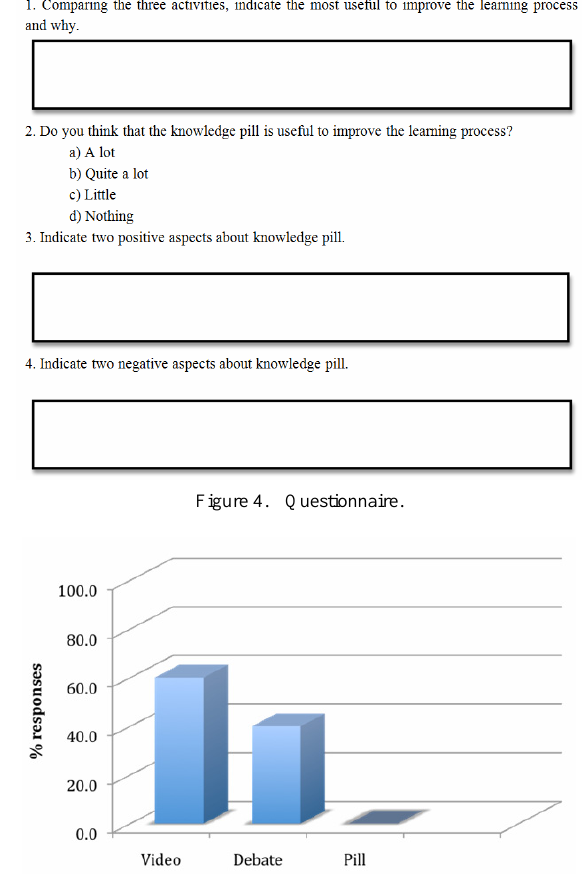
Figure 5. Preferences of students about the used learning